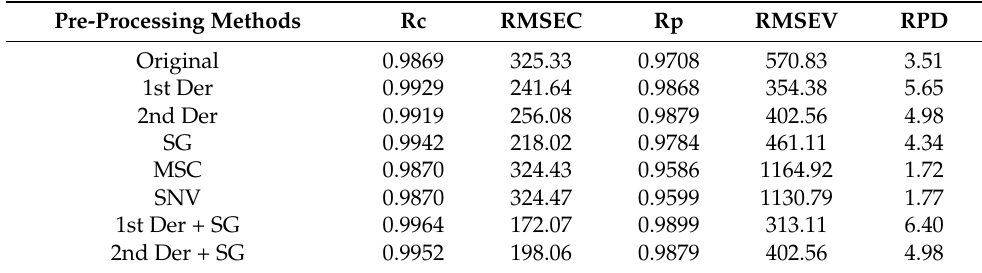
Table 5. Comparing PLSR results after extracting spectral features by synergy interval partial least